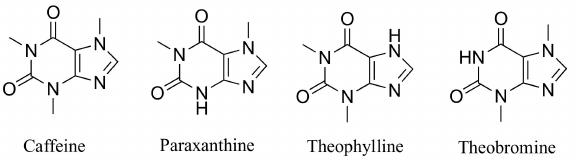
Figure 1. Chemical structure of caffeine and its primary metabolites. Reproduced with permission from reference